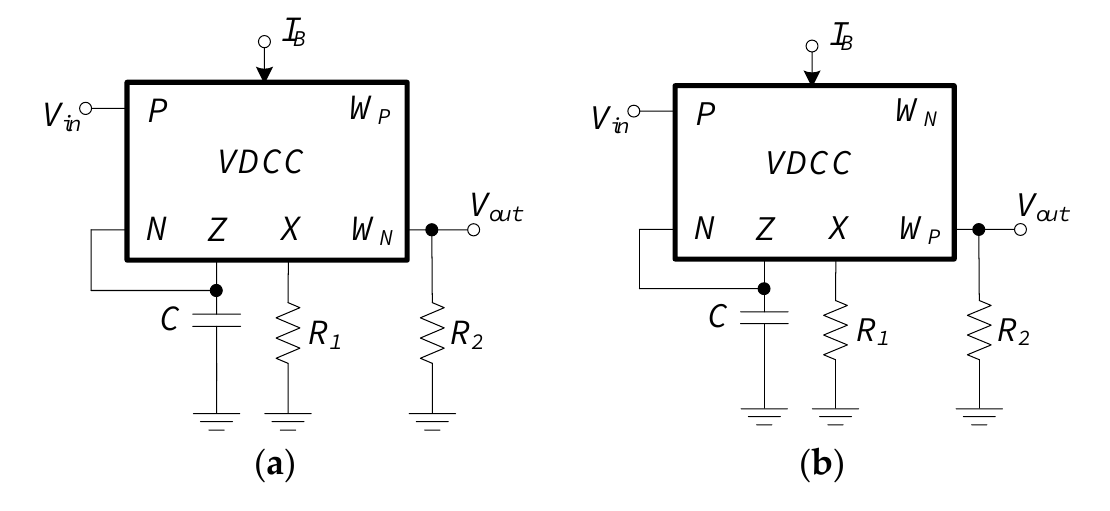
Figure 3. VDCC-based lossy integrators ( a ) inverting configuration ( b ) non-inverting configuration. Based on Equation (3), the k = R 2 /R 1 and α = C/g m . According to Equations (9) and (10),